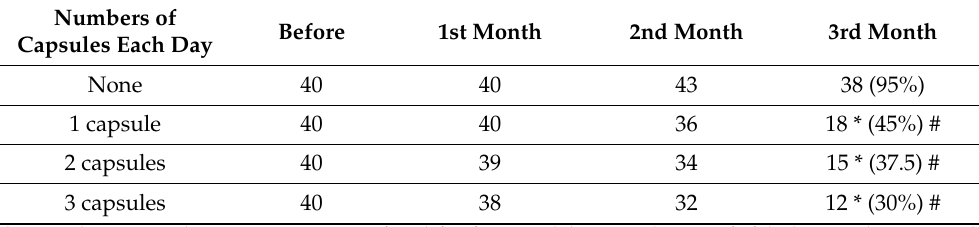
Table 1. The changes in patients with ocular vitreous before and after taking the mixed fruit enzyme capsules over a three-month period in Experiment